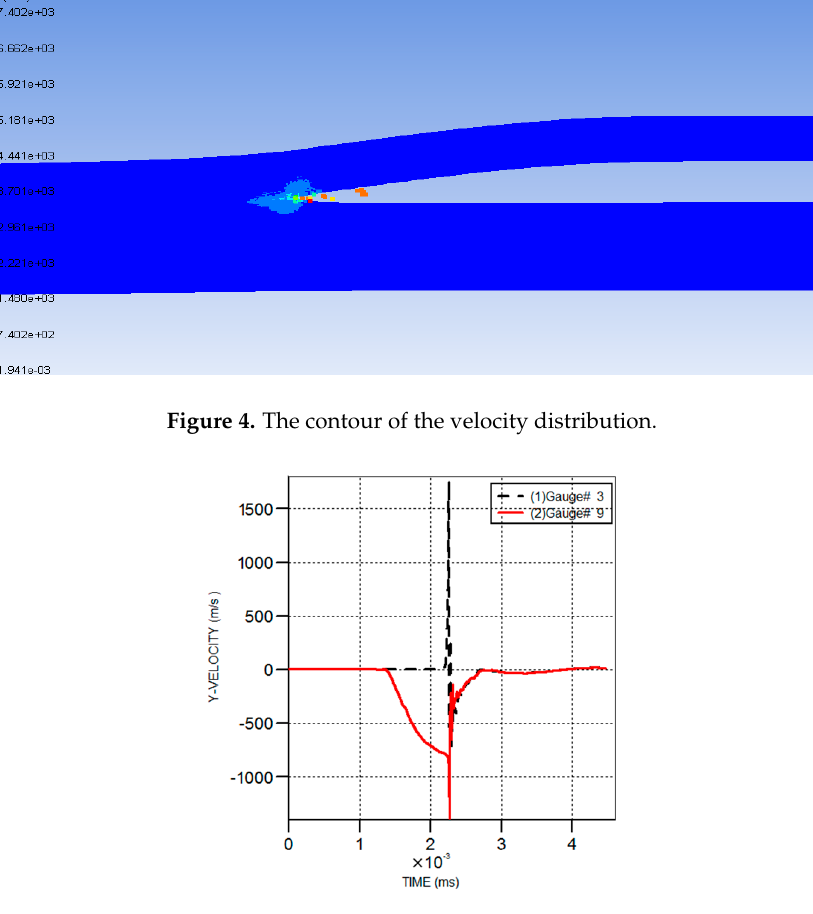
Figure 5. The Y ‐ direction velocity ‐ time curves of the special points.